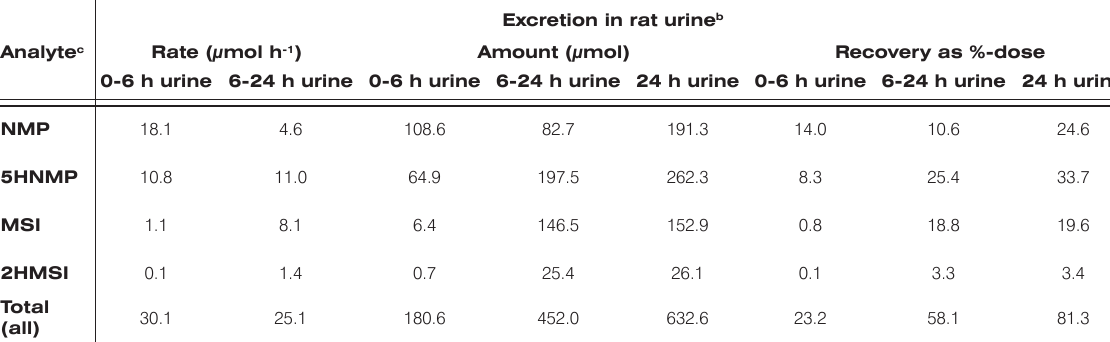
Table 1. Urinary disposition of N-methyl-2-pyrrolidone (NMP) after a single intragastric dose